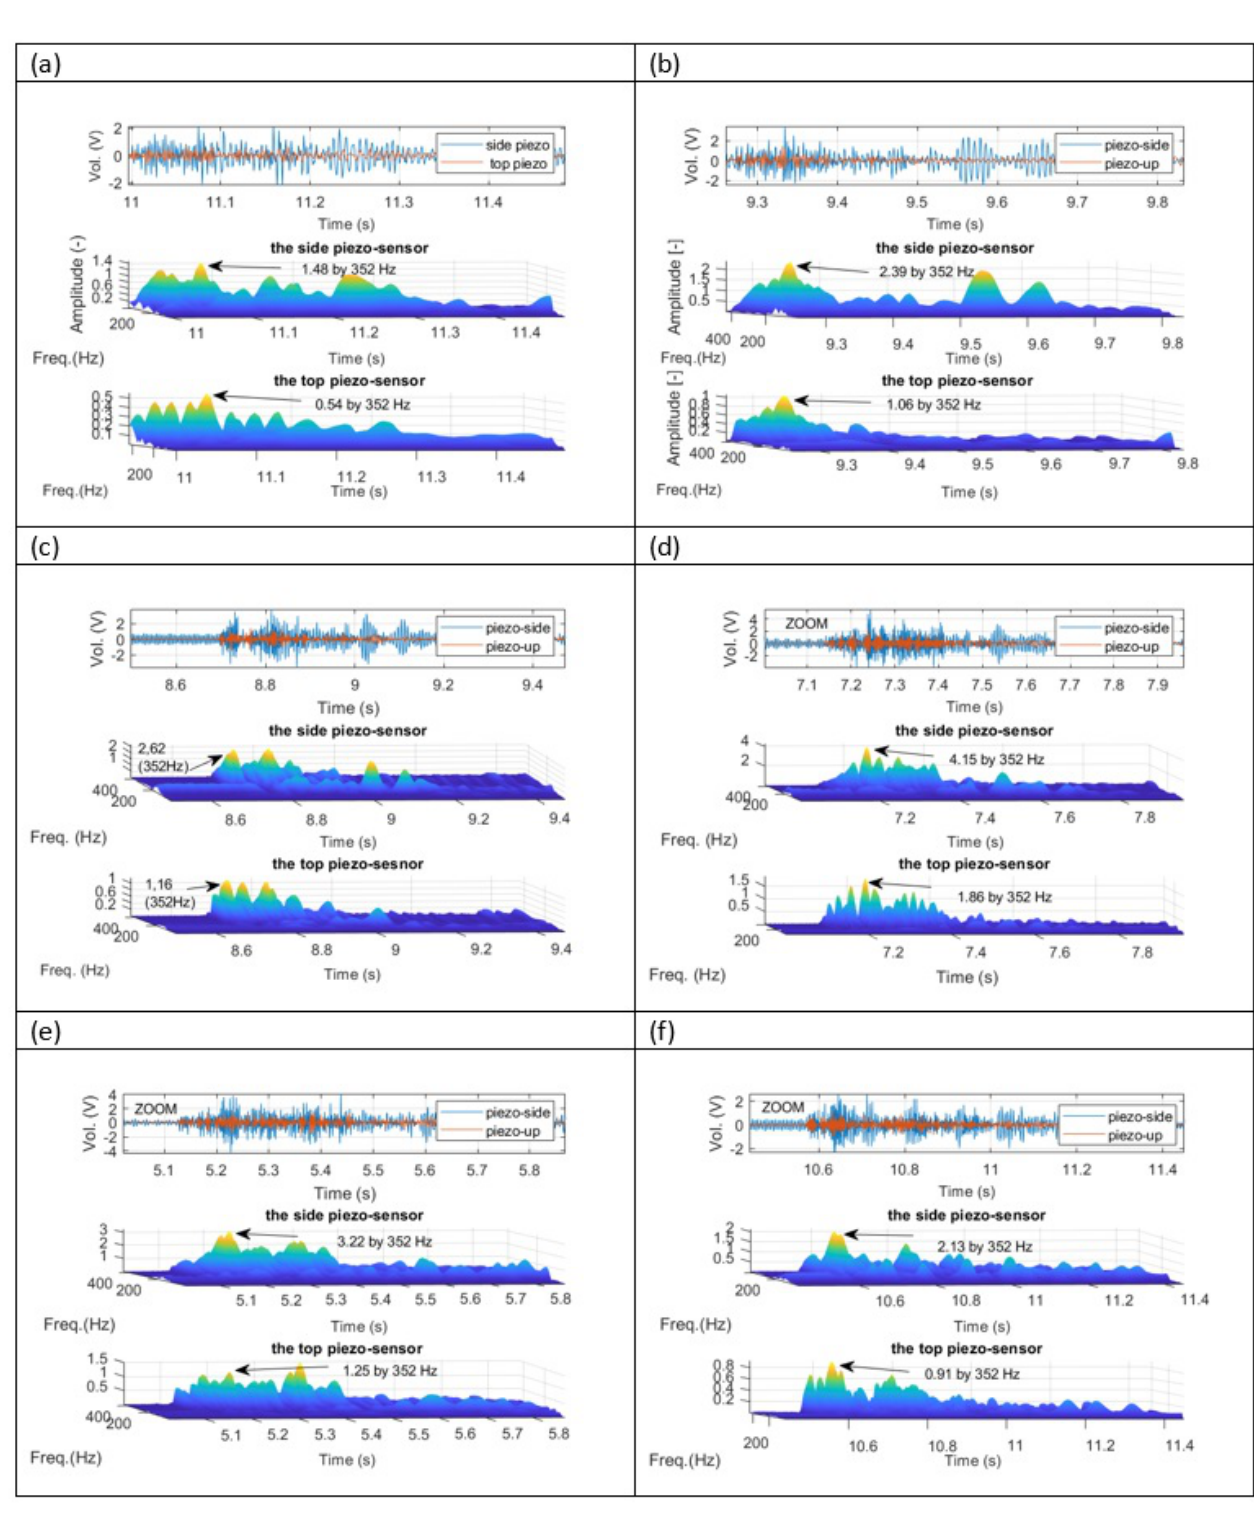
Figure 14. Wavelet analysis of the recorded voltages signals from both piezo composites sensors corresponding to response time in Figure 12 for damaged BLDC motor and various values of PWM duty cycle (( a ) results for 30% duty cycle PWM signal, ( b ) results for 35% duty cycle PWM signal, ( c ) results for 40% duty cycle PWM signal, ( d ) results for 45% duty cycle PWM signal, ( e ) results for 50% duty cycle PWM signal, ( f ) results for 55% duty cycle PWM